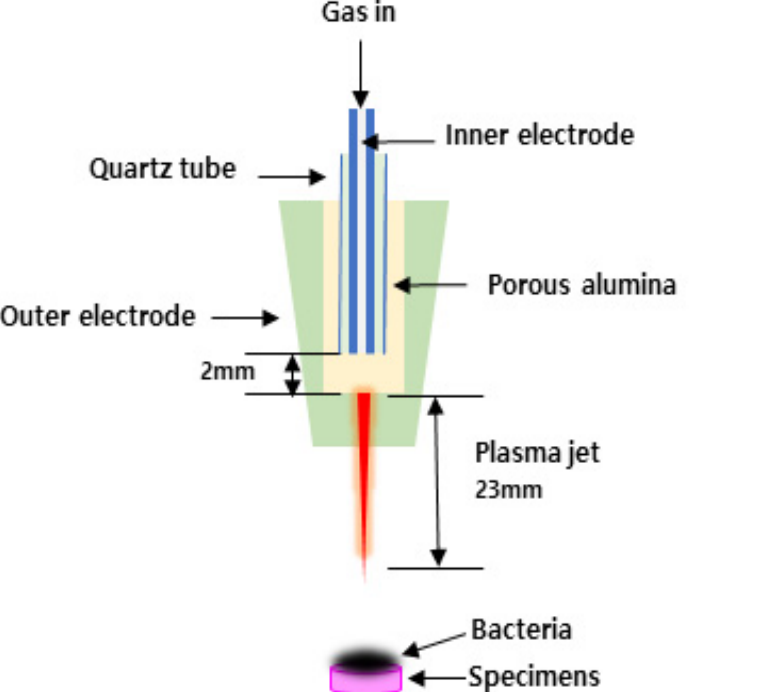
Figure 1. Schematic diagram of non-thermal atmospheric pressure plasma treatment on the impres- sion